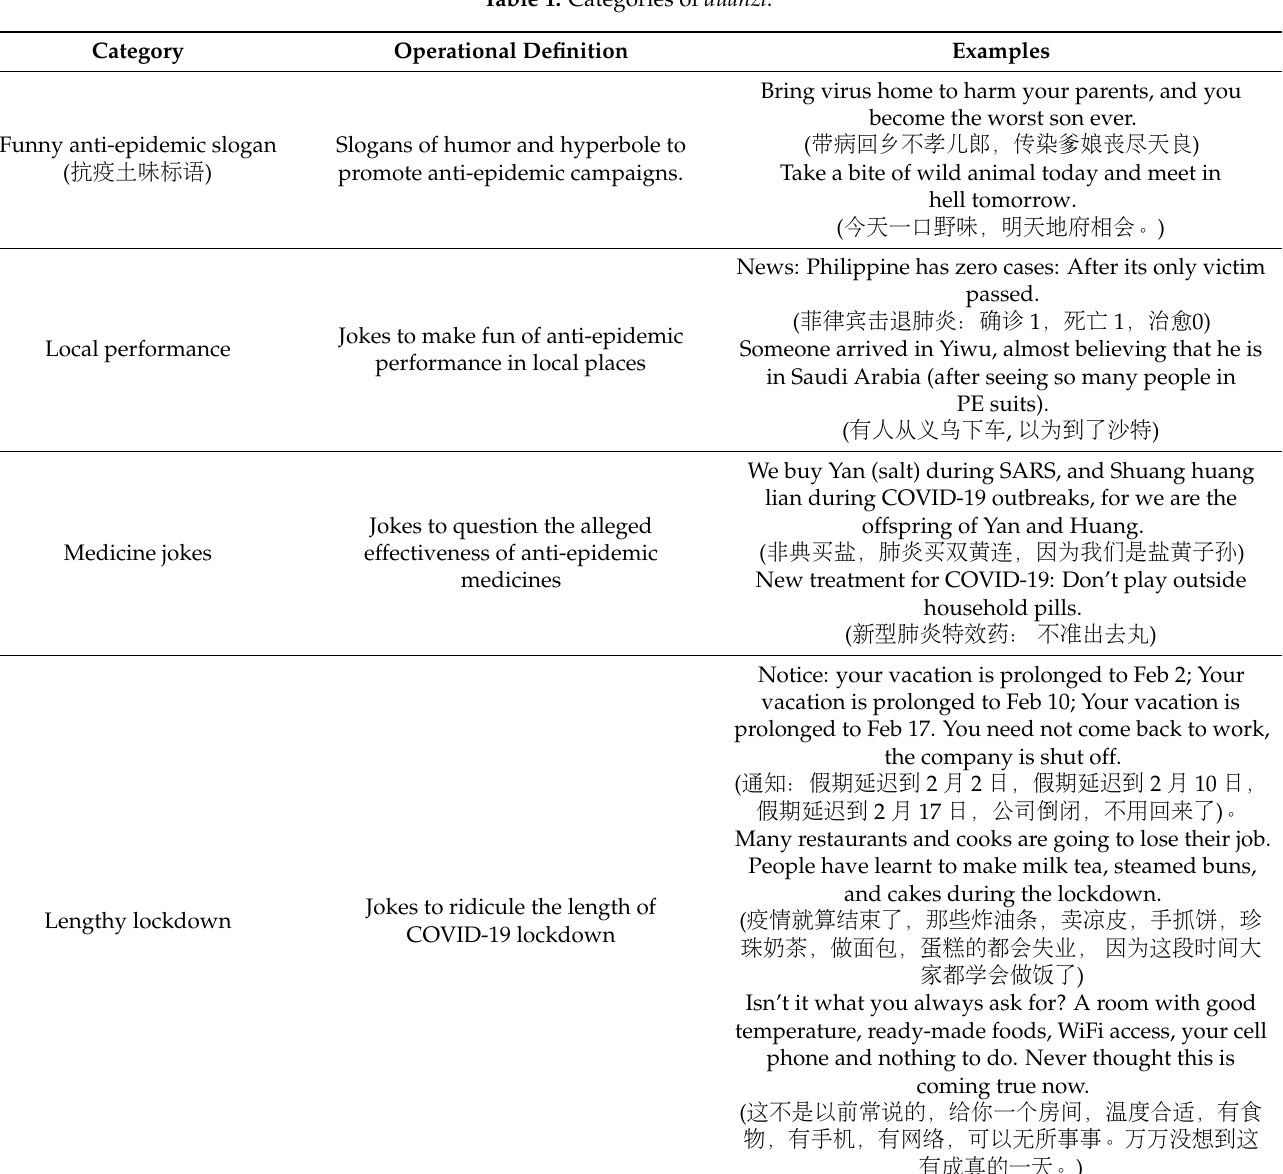
Table 1. Categories of duanzi